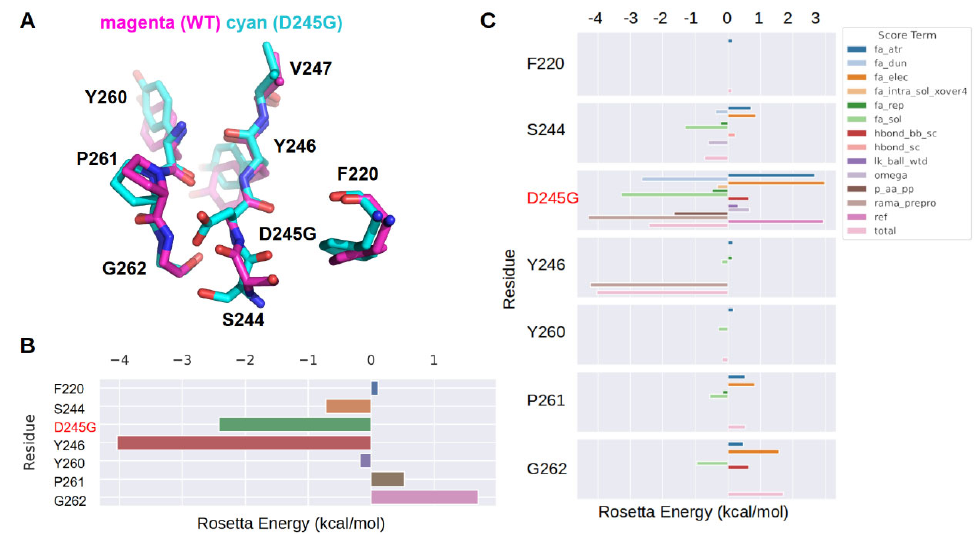
Figure 7. Energy contribution to the favored Rosetta predicted ∆∆ G for the D245G mutant. ( A ) Structural models of residue 245 and its interacting residues are shown based on representative snapshots at 200 ns of the MD simulation trajectories for the WT and D245G. The residues are shown as sticks. Nitrogen and oxygen atoms are colored in blue and red, respectively. Carbon atoms were colored in cyan for the WT and magenta for D245G. ( B ) The Rosetta ∆∆ G energy (kcal/mol) is shown for D245G and its interacting residues. ( C ) Decomposition of the change in the Rosetta energy to indi ‐ vidual energy score terms for residues. The energy score terms are color ‐ coded. Below is the de ‐ scription for the score terms [21]. Fa_atr: attractive energy between two atoms on different residues separated by distance d; Fa_dun: probability that a chosen rotamer is native ‐ like given the backbone angles 𝜙 and 𝜓 ; Fa_elec: energy of the interaction between two non ‐ bonded charged atoms sepa ‐ rated by distance d; Fa_intra_sol_xover4: Gaussian exclusion implicit solvation energy between pro ‐ tein atoms in the same residue; Fa_sep: repulsive energy between two atoms on different residues separated by distance d; Fa_sol: Gaussian exclusion implicit solvation energy between protein at ‐ oms in different residues; hbond_bb_sc: energy of backbone ‐ side chain hydrogen bonds; hbond_sc: energy of side ‐ chain ‐ to ‐ side ‐ chain hydrogen bonds; lk_ball_wtd: orientation ‐ dependent solvation of polar atoms assuming an ideal water geometry: omega: backbone ‐ dependent penalty for cis 𝜔 dihedrals that deviate from 0° and trans 𝜔 dihedrals that deviate from 180°; p_aa_pp: probability of amino acid identity given the backbone angles 𝜙 and 𝜓 : rama_prepro: probability of the backbone angles 𝜙 and 𝜓 given the amino acid type; ref: reference energies for amino acid types; total: the change in the Rosetta energy.